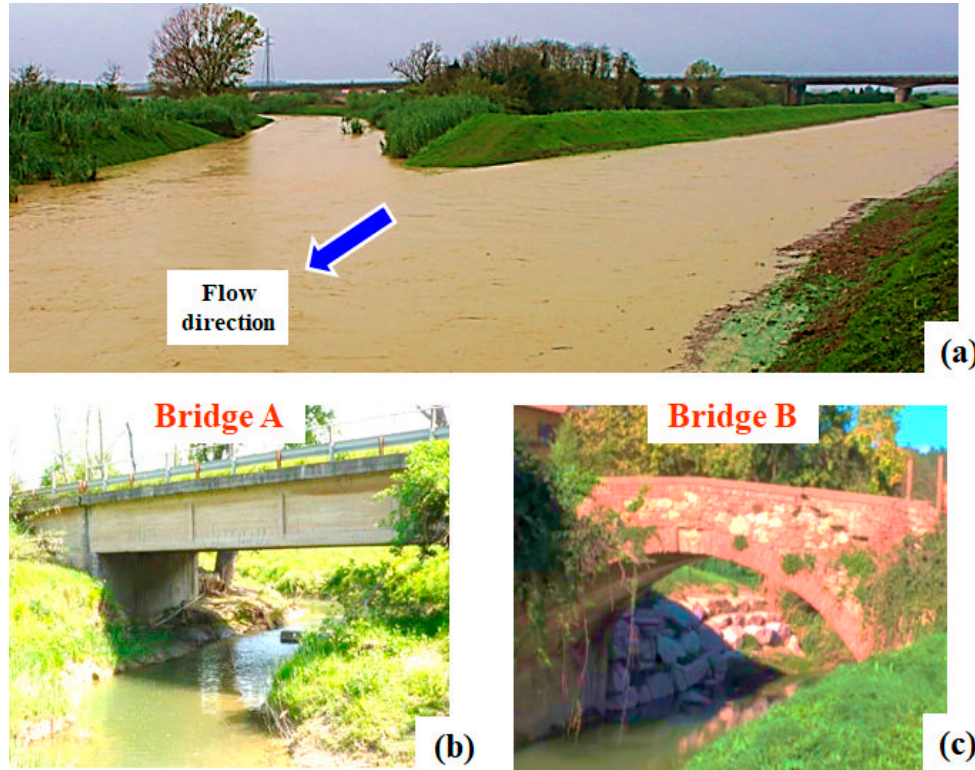
Figure 3. ( a ) Effects of the September 2017 flooding event on Morra Creek hydraulic conditions. The blue arrow indicates the flow direction. Detailed views of ( b ) “Bridge A” (43°33 ′ 23 ″ N–10°28 ′ 41 ″ E) and ( c ) “Bridge B” (43°33 ′ 26 ″ N–10°28 ′ 44 ″ E) cross-sections and structures.